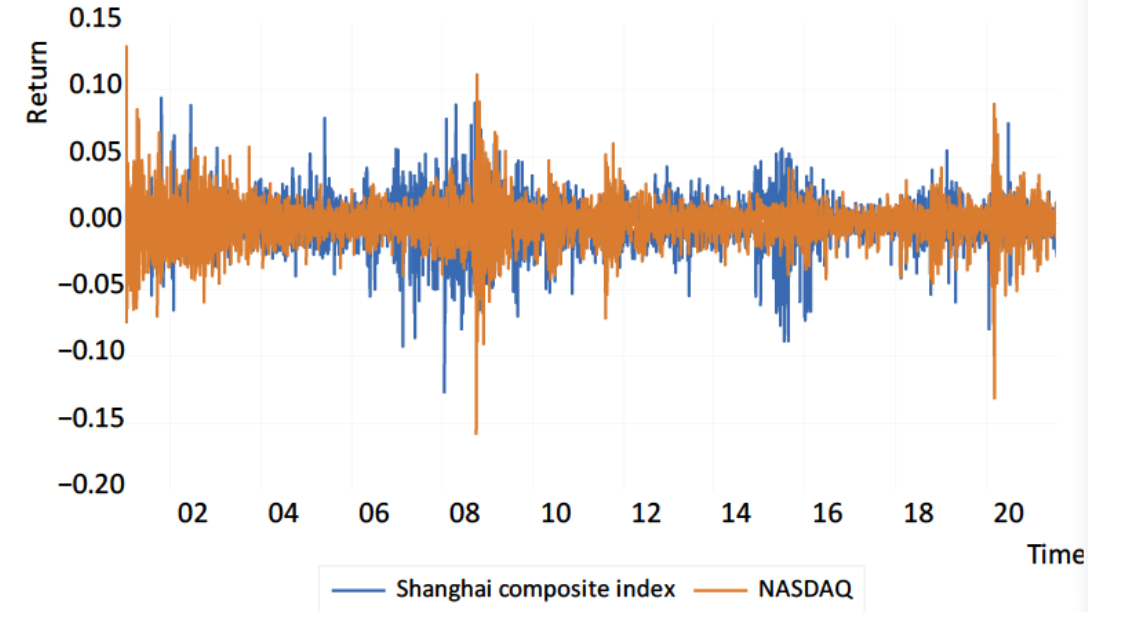
Figure 2. Log returns of SHCI and NASDAQ from January 2001 to July 2021.